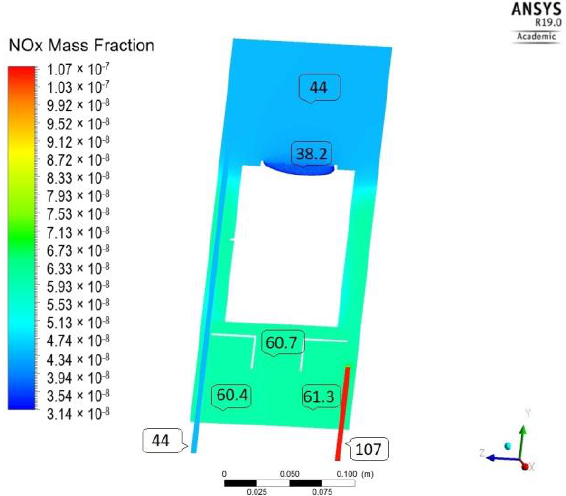
Figure 7. NO x concentration distribution T300_GO / 107 ppb (optimized L-H model parameters).